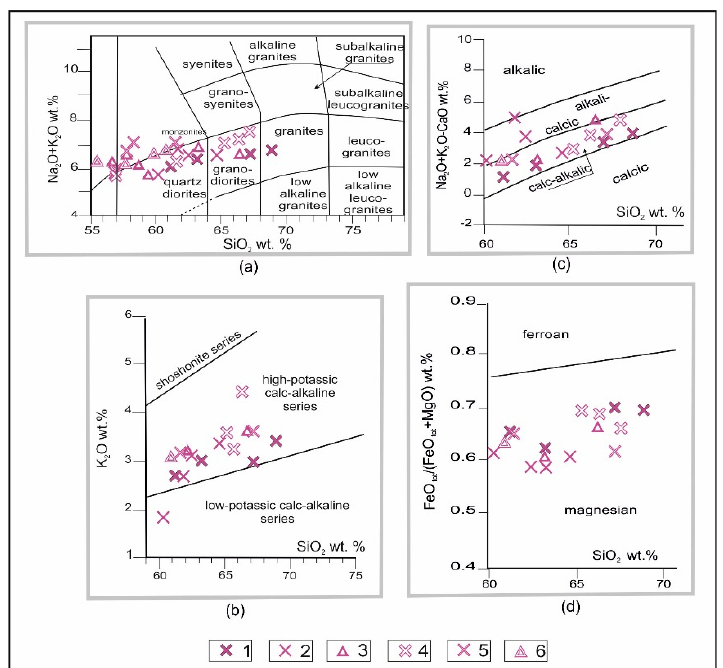
Figure 9. Petrochemical characteristics of igneous rocks of the calc- alkaline series of the EF MOOB framing on classification diagrams: ( a ) (Na 2 O + K 2 O) − SiO 2 [25]; ( b ) K 2 O − SiO 2 [26]; ( c ) (Na 2 O + K 2 O − CaO) − SiO 2 and ( d ) FeO tot /(FeO tot + MgO) − SiO 2 by [27]. Legend: of southern framing-plutonic granitoids (1), hypabyssal granitoids (2), volcanoes (3); of northern framing-plutonic granitoids (4), hypabyssal granitoids (5), volcanoes (6).